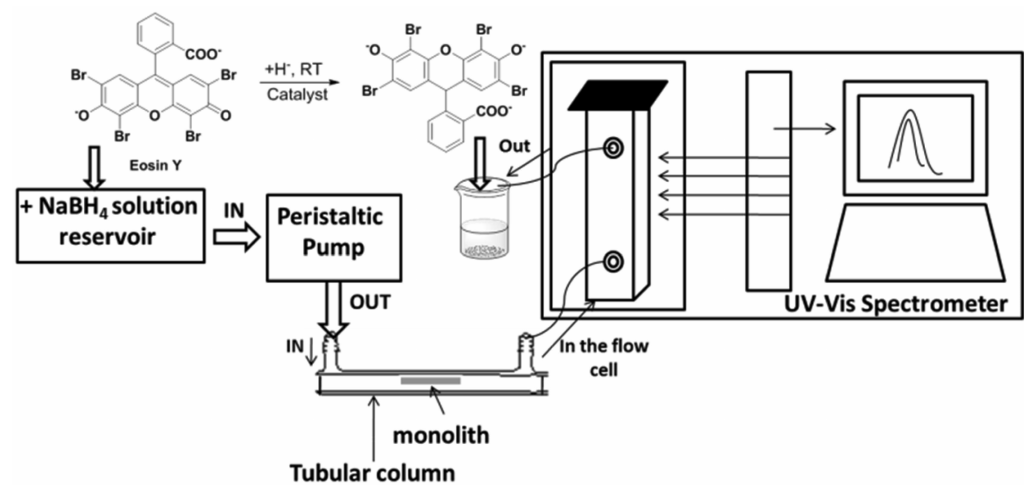
Figure 2. The typical continuous monolithic microreactor used for the hydrogenation of EO.